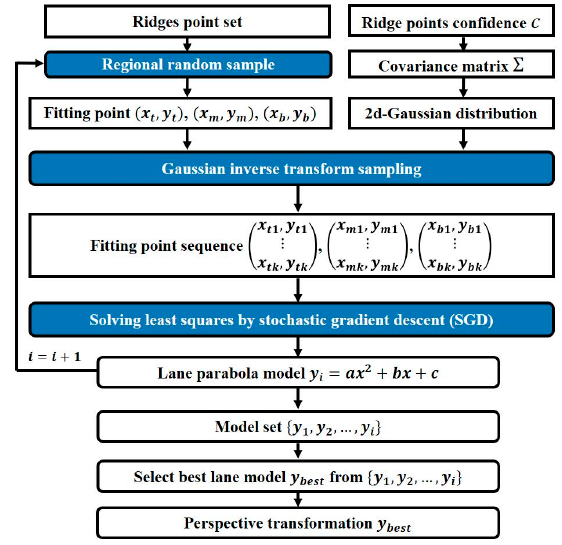
Figure 8. Regional gaussian distribution random sample consensus (G-RANSAC) land fitting block diagram.